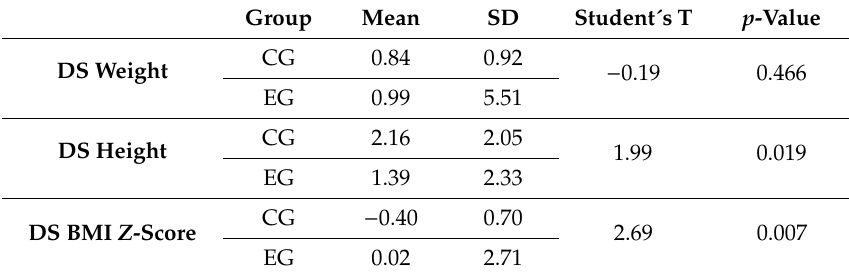
Table 3. Comparison of di ff erential scores of anthropometric variables according to the type of group. Group Mean SD Student´s